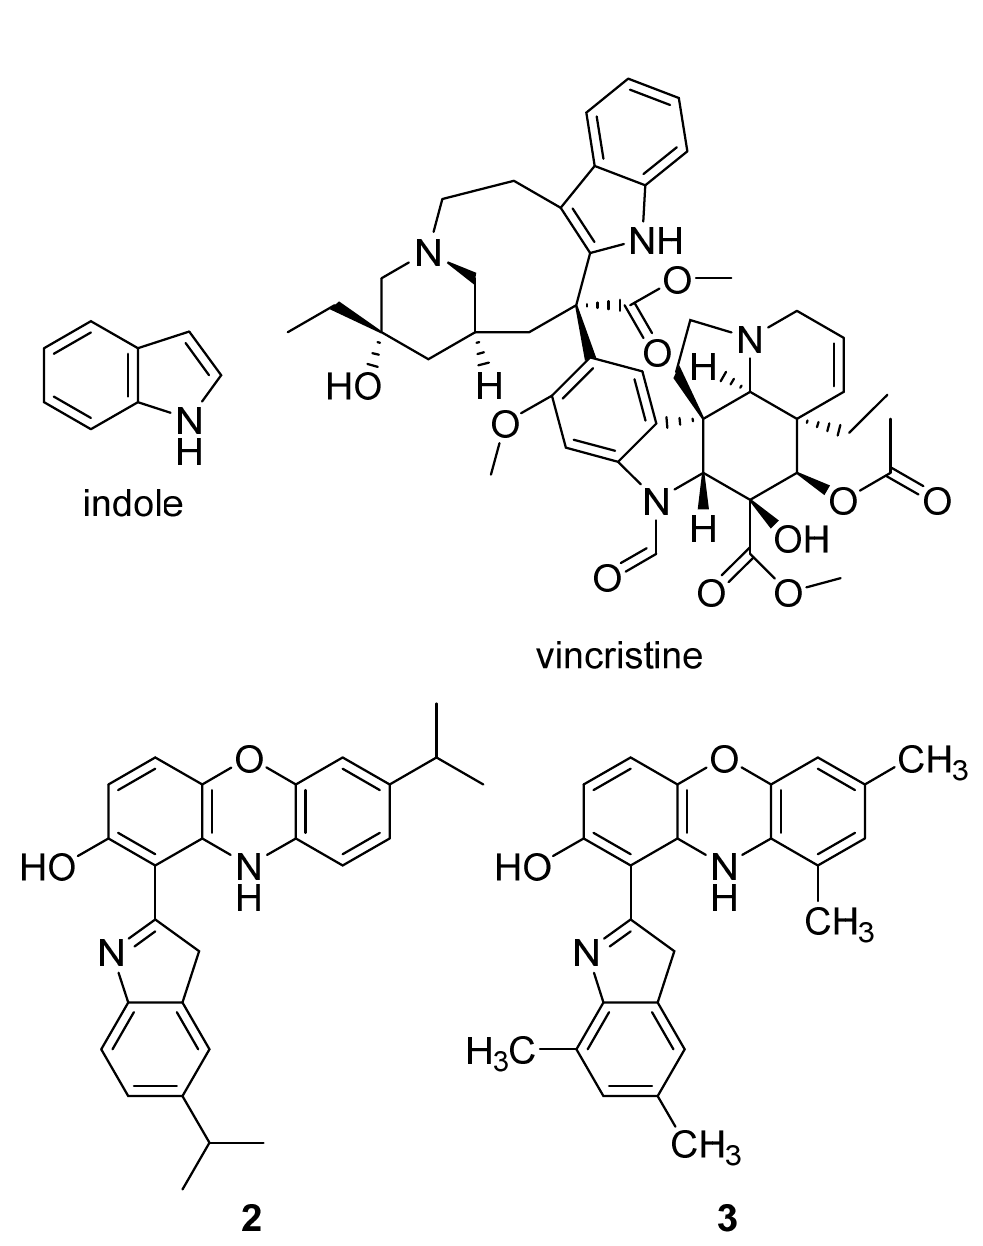
Figure 9. Structures of indole, the anticancer drug vincristine and the most active indole derivatives. Therefore, the cytotoxicity of certain indol derivatives was tested by Nunewar et al. on A549 (lung), MG-63 (bone), BT-474 (breast), Hep G2 (liver) and HCT116 (colon) hu- man cancer cell lines, along with a normal line of lung epithelial tissue (L-132). All the derivatives tested showed remarkable IC 50 values. The most inhibited cell line was A549, by the derivative 2 (IC 50 = 3.71 ± 0.57 µ M), characterized by two isopropyl substituents (Figure 9), and followed by compound 3 (IC 50 = 4.43 ± 0.64 µ M). In addition, 2 was the only derivative with the previously explained DNA intercalation capacity. These results confirm that hybrid compounds are a promising alternative in the search for new anticancer